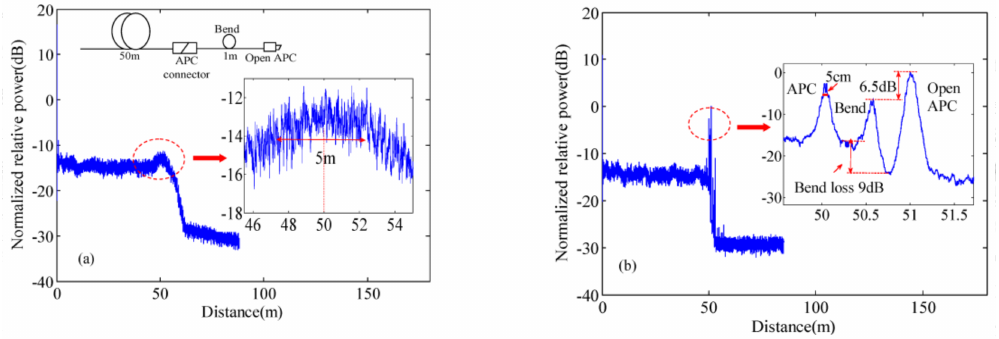
Figure 6. Comparison between OFDR traces for 51 m FUT using ( a ) standard FFT and ( b ) NUFFT (Reprinted from Ding et al. [29] with permission of AIP Publishing LLC; copyright